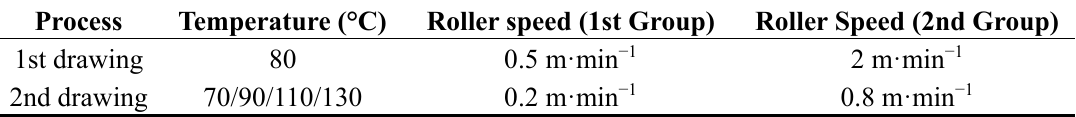
Table 2. Solid-state drawing parameters (to give different DR ).